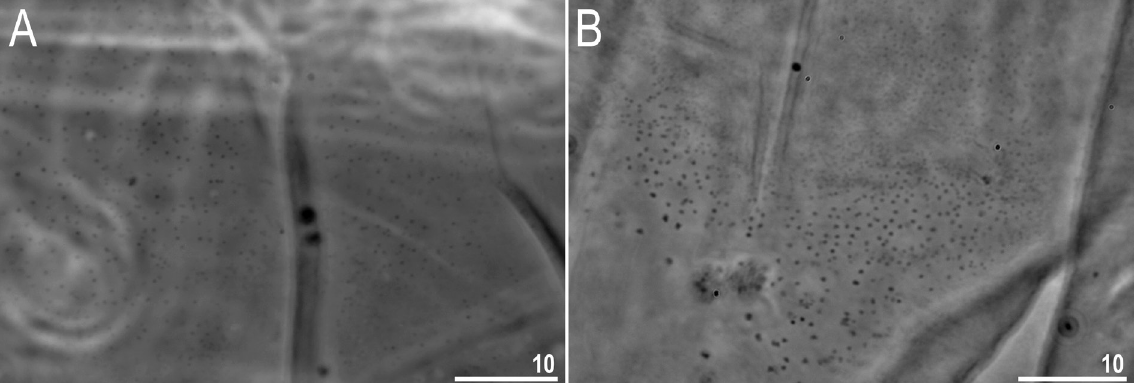
Fig. 20. Tenuibiotus voronkovi (Tumanov, 2007). Body granulation seen in PCM. A . Uniformly distributed granulation of uniform size on the dorso-medial part of the body (cephalic region, paratype). B . Patch of dorso-lateral granulation composed of granules of different size (holotype). Scale bars in